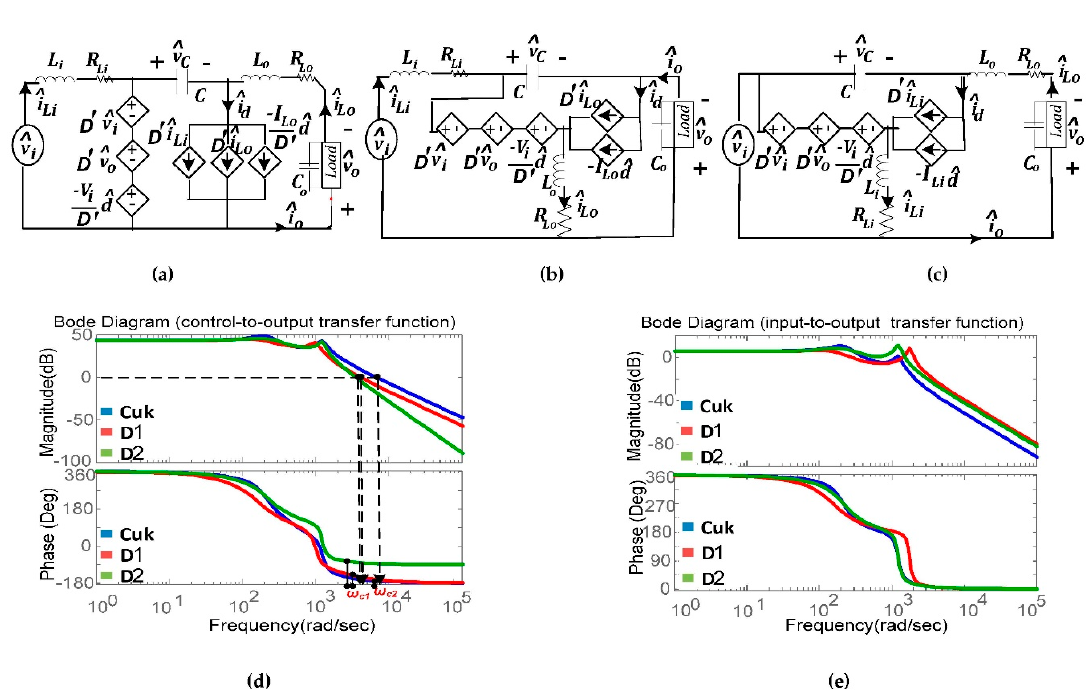
Figure 2. Converters’ small signal models in continuous current mode (CCM): ( a ) CUK model; ( b ) D1 model; ( c ) D2 model; ( d ) Bode plot of control-to-output and ( d ) input-to-output transfer functions for the three investigated converters.